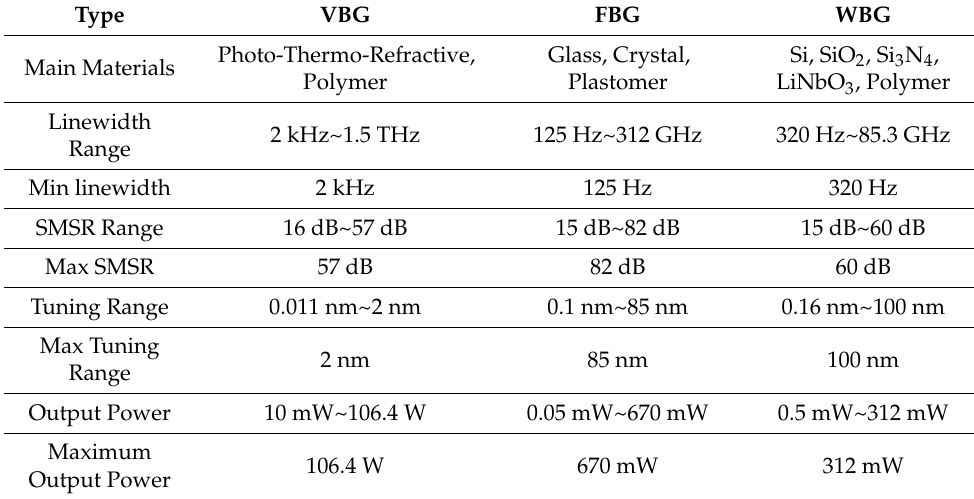
Table 4. Comparison of different kinds of